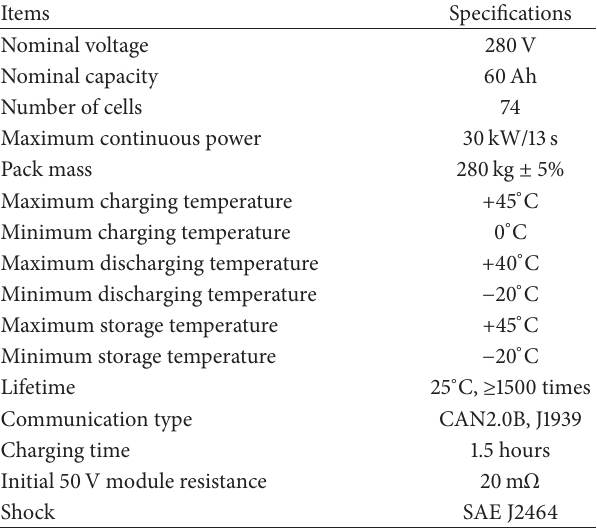
Table 2: Parameters of the battery pack.